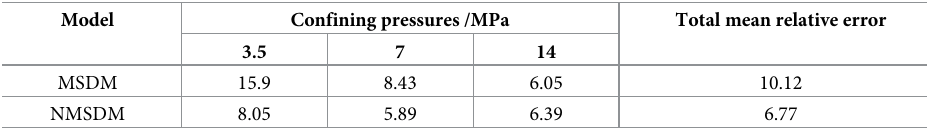
Table 4. Mean relative errors of theoretical models for marble